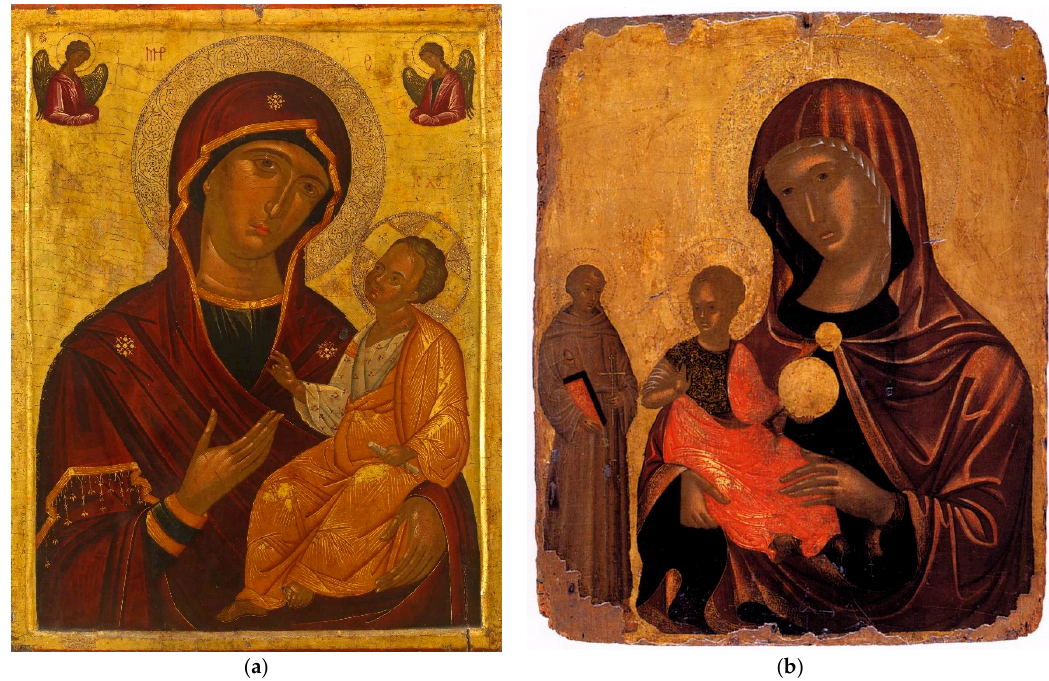
Figure 5. ( a ) The Virgin Hodegetria , 16th century, Venice, Istituto Ellenico di Studi Bizantini e Postbizantini (image in the public domain); ( b ) Nikolaos Tzafoures, Madre della Consolazione with Saint Francis of Assisi, Athens, Byzantine and Christian Museum (image in the public domain).